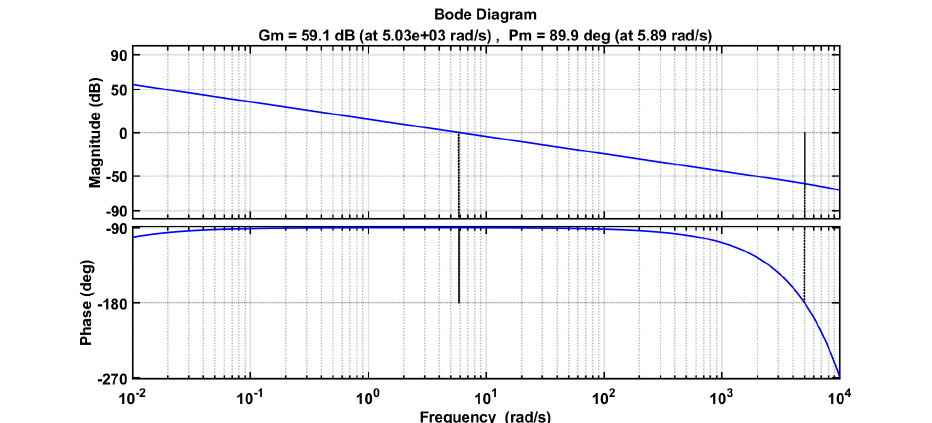
Figure A3. Bode diagram for transfer function of voltage balancing